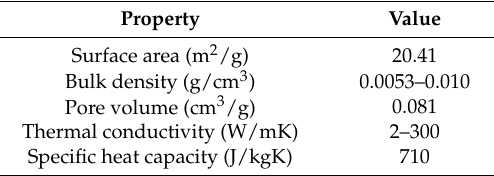
Table 2. Physical properties of xGnP